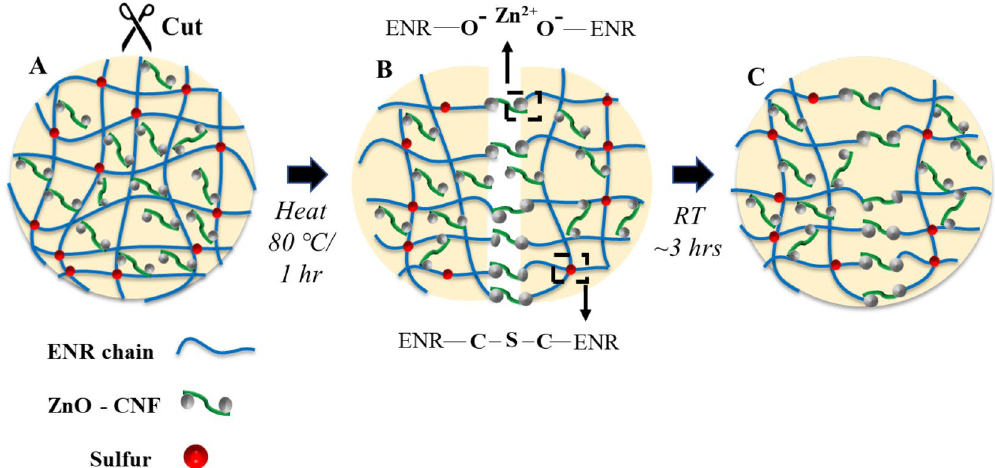
Figure 3. Proposed self-healing mechanism of ENR based SH glove. ( A ) Damages to the ENR matrix due to cut. ( B ) Self-repairing action. ( C ) Complete restoration of the original structural integrity after 3 h at room